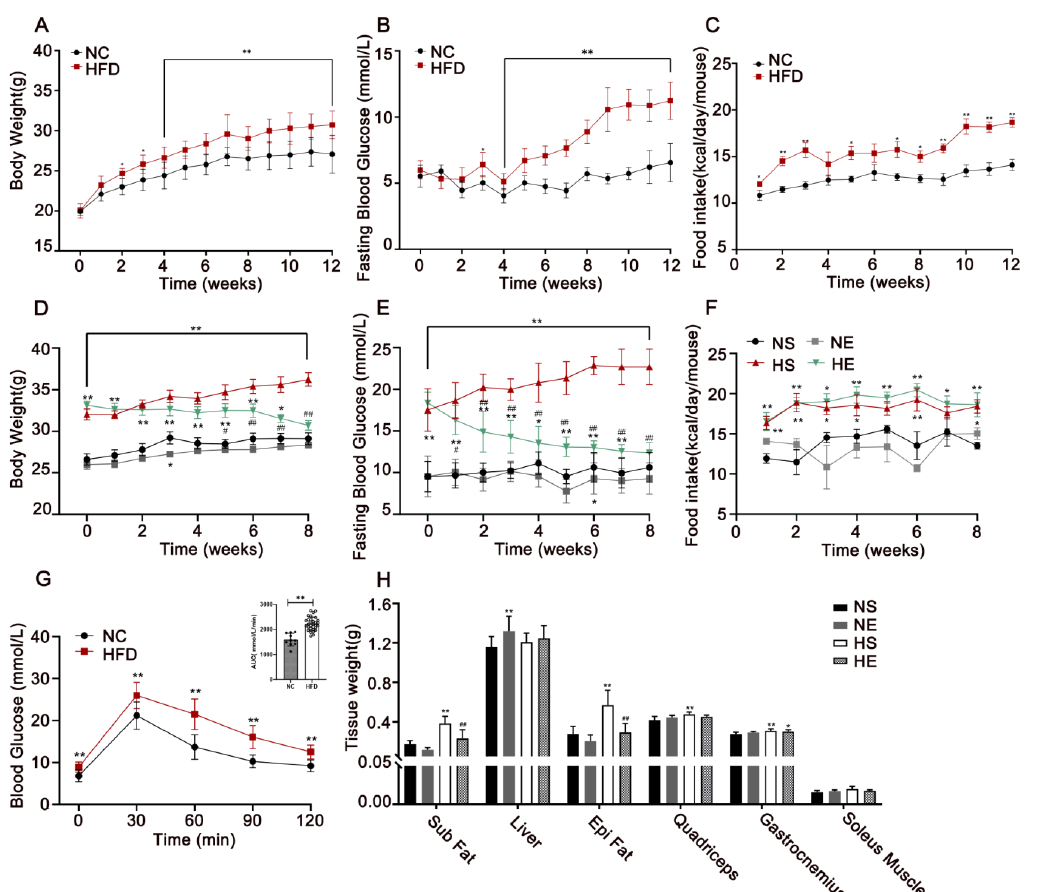
Figure 2. Aerobic exercise attenuated HFD-induced adiposity. ( A ) Body weight, ( B ) fasting blood glucose, and ( C ) food intake during the 12-week feed. ( D ) Weekly changes in body weight, ( E ) fasting blood glucose, and ( F ) food intake during eight weeks of exercise. ( G ) Glucose tolerance test (GTT) and AUC GTT after 12 weeks of the high-fat diet. ( H ) Tissue weights of the mice. NC, normal control, n = 20; HFD, high-fat diet, n = 30. NS, normal sedentary; NE, normal + exercise; HS, HFD sedentary; HE, HFD + exercise. Sub Fat, subcutaneous fat, Epi Fat, epididymal fat. Values are means ± SD ( n = 8 per group). * p < 0.05, ** p < 0.01 vs. NS group; # p < 0.05, ## p < 0.01 HS group.